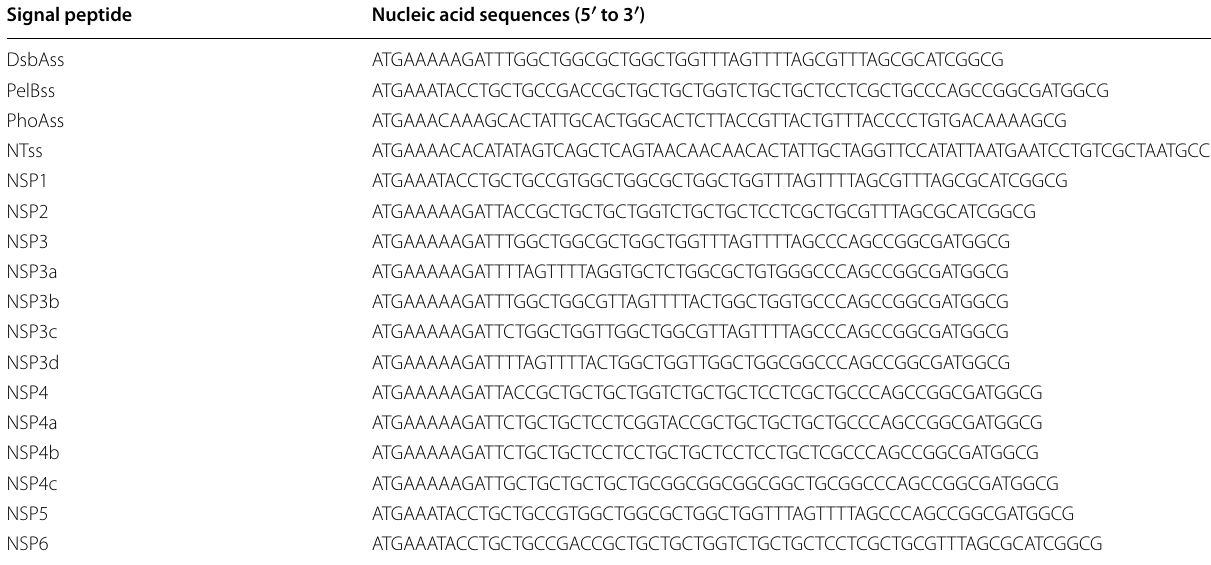
Table 3 Nucleic acid sequences of bacterial and novel signal peptides used in this study Signal peptide Nucleic acid sequences (5 ′ to 3 ′